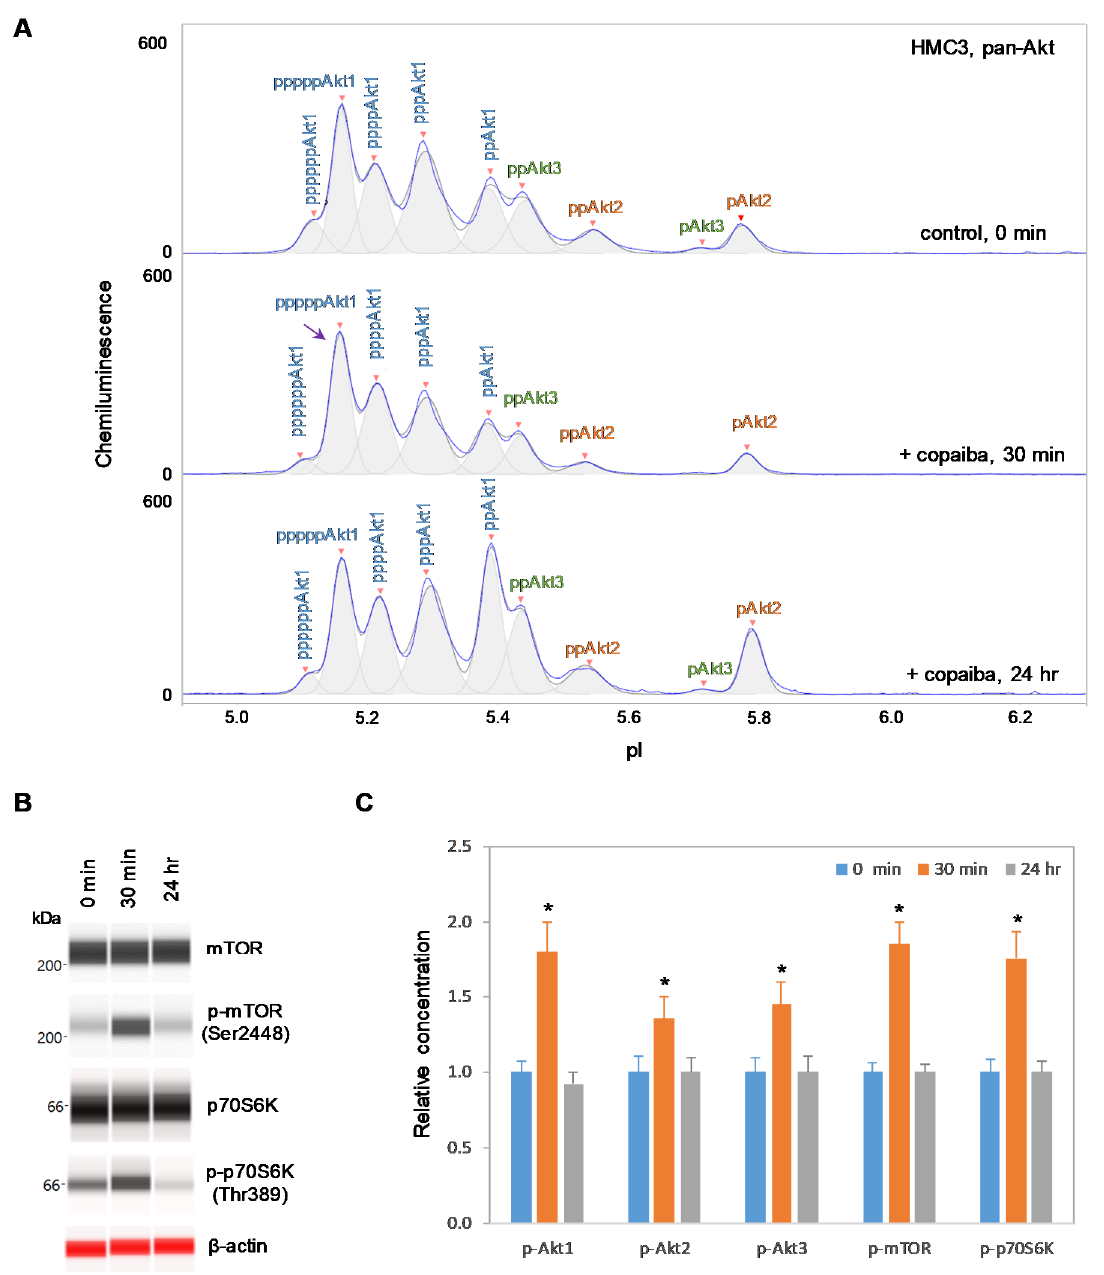
Figure 3. Positive regulation of the pI3K/Akt/mTOR signaling pathway in HMC3 microglial cells by copaiba essential oil. ( A ) cIEF electropherograms of pan-Akt in HMC3 cells before (0 min) and after (30 min and 24 h) treatment with copaiba essential oil. Peaks associated with Akt isoforms are labeled and color-coded: Akt1 (blue), Akt2 (orange), and Akt3 (green). The purple arrow points to the highly phosphorylated Akt1 peak that transiently increased following treatment with copaiba essential oil. Note the relative intensity of this peak compared to that of other peaks in the cIEF electropherogram. ( B ) Expression levels of the mTOR and p70S6K phosphoisoforms as a function of time after treatment with copaiba essential oil. β-Actin served as the loading control. ( C ) Relative concentrations of Akt1, Akt2, Akt3, mTOR, and p70S6K phosphoisoforms as a function of time after treatment with copaiba essential oil. The relative concentration describes the fold change in the expression level of a protein phosphoisoform after treatment compared to that under the control condition. The error bars indicate the standard deviations of six repeated measurements per experimental condition. The asterisks indicate a statistical significance of p ≤ 0.05 versus the control. HMC3 cells were treated with 100 ng / mL copaiba essential oil.